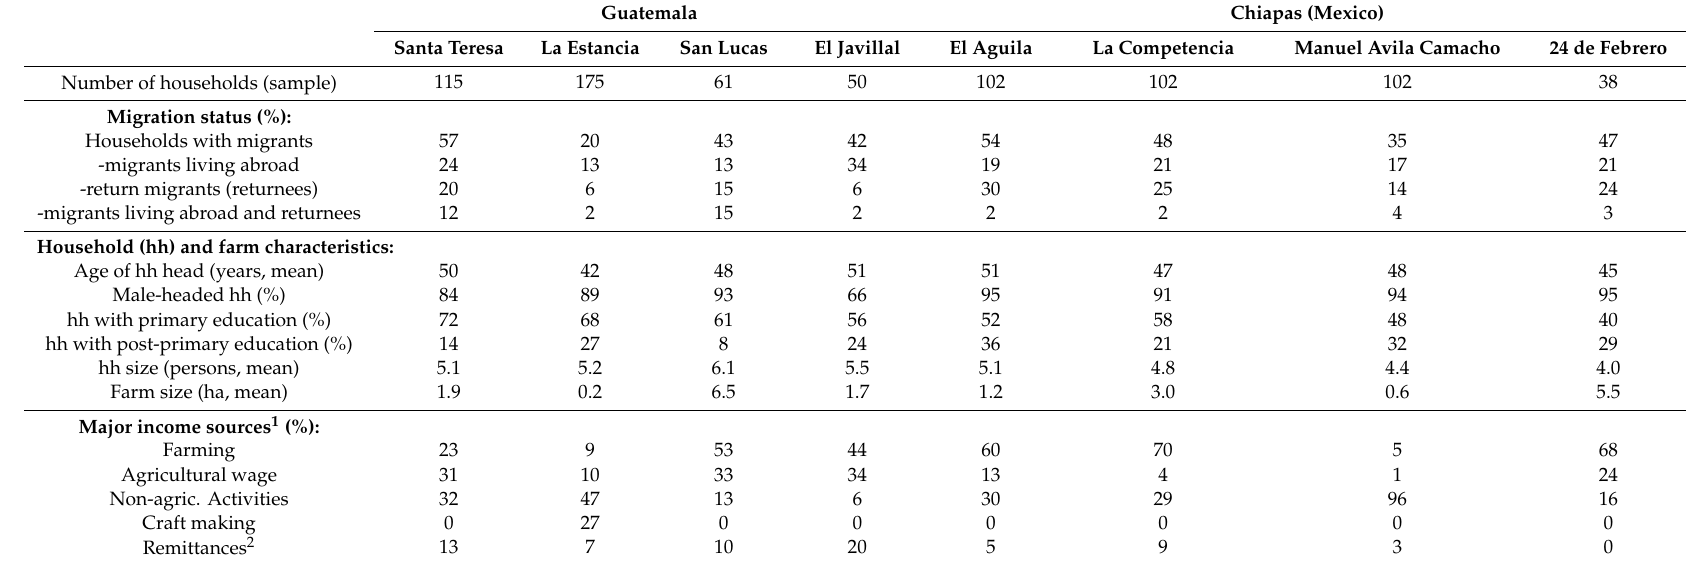
Table 2. Basic household characteristics in the eight